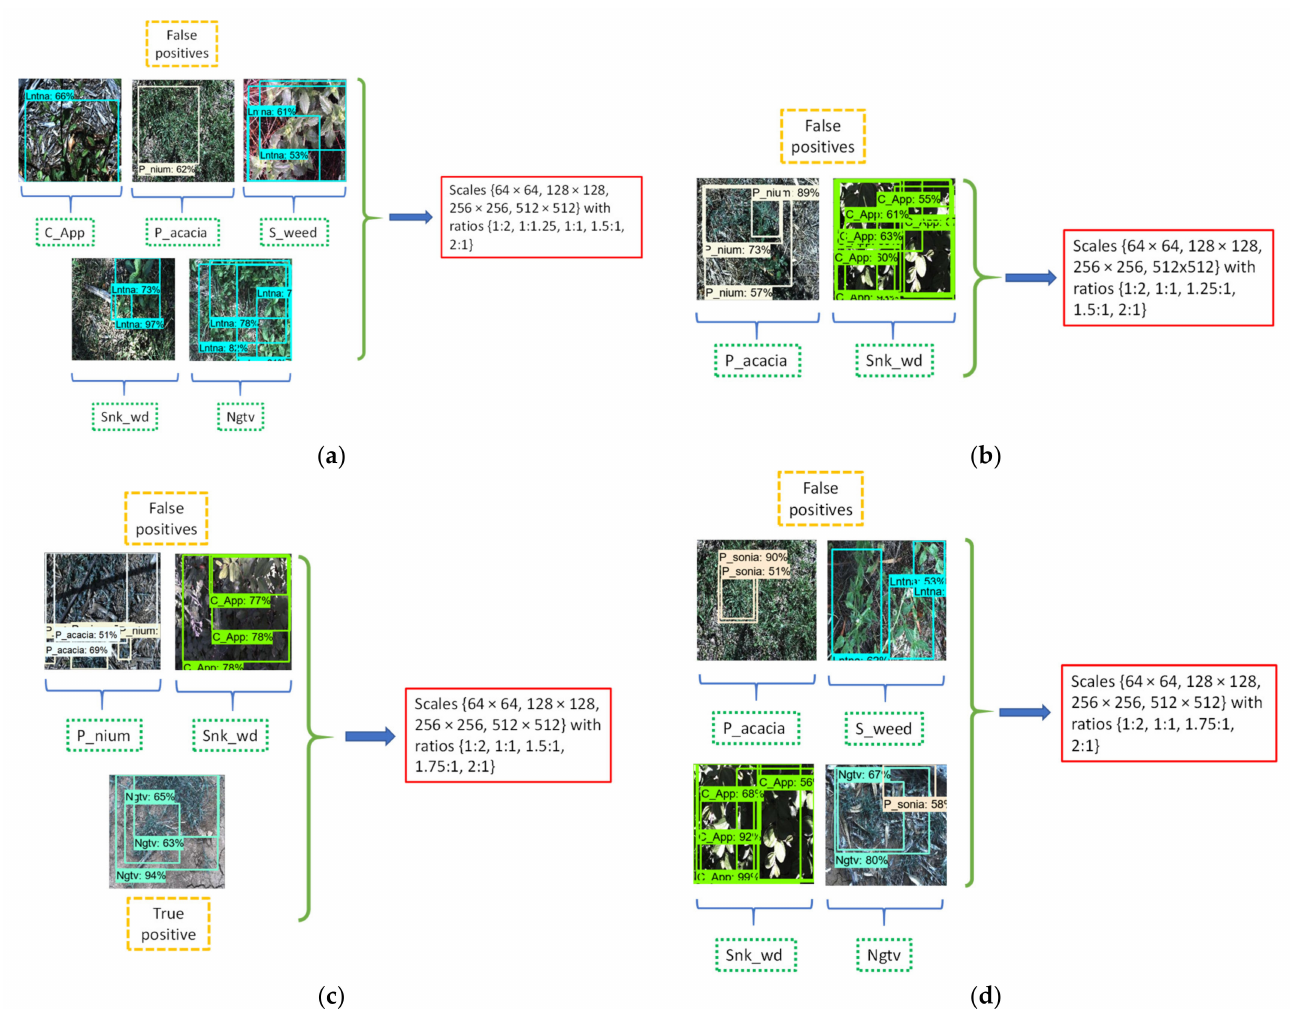
Figure 12. Detection results after the addition of various aspect ratios to the default ratios: ( a ) presents false positives with aspect ratios of 1:1.25 and 1.5:1; ( b ) presents false positives with aspect ratios of 1.25: 1 and 1.5:1; ( c ) presents true and false positives with aspect ratios of 1.5:1 and 1.75:1; ( d ) presents false positives with an aspect ratio of